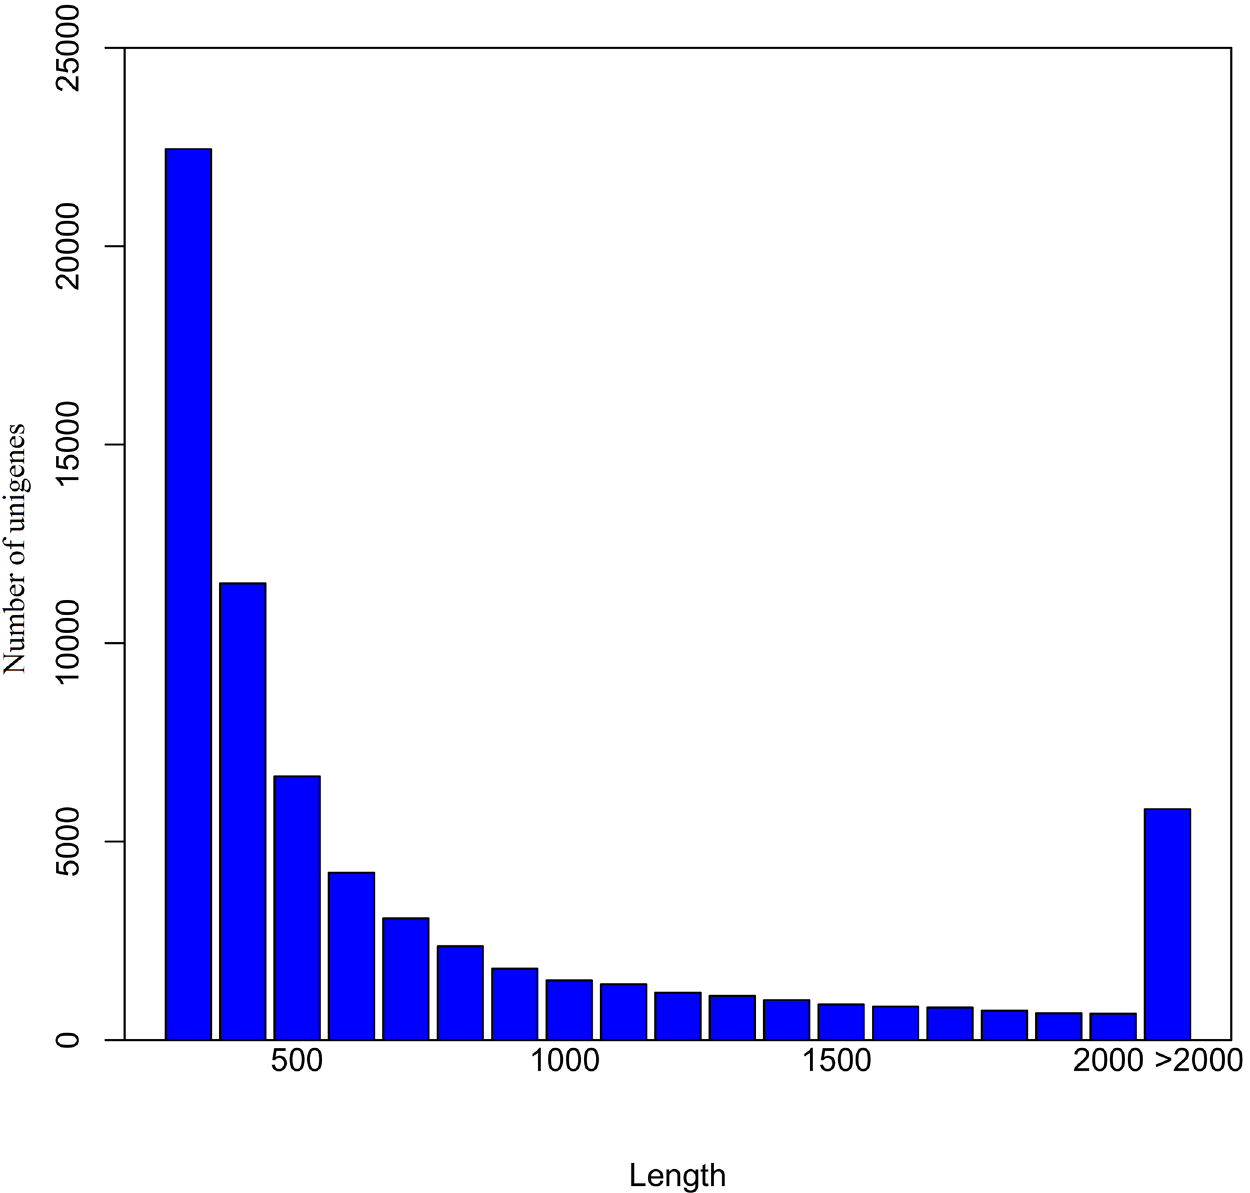
Fig 2. Length distributions of the unigenes. The X-axis lists the length of unigenes, and the Y-axis lists shows the number of unigenes of that